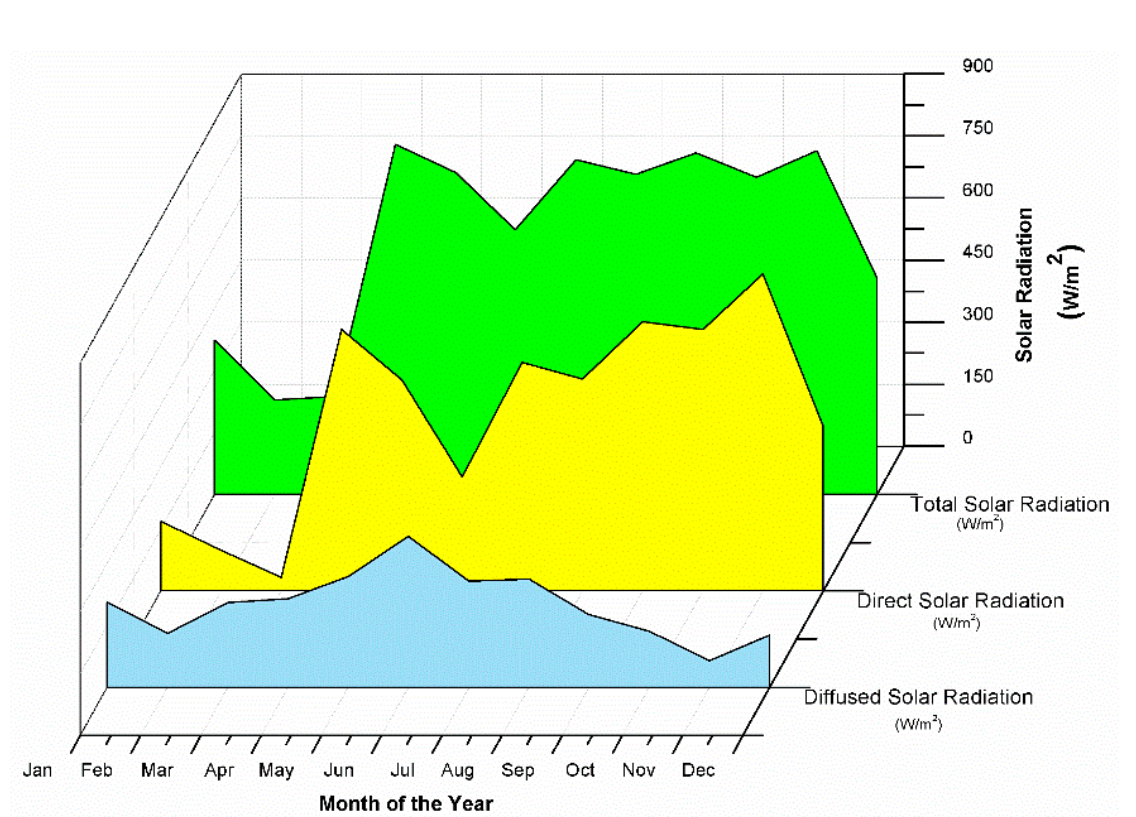
Figure 11. Distribution of total, beam/direct, and diffused solar radiation.